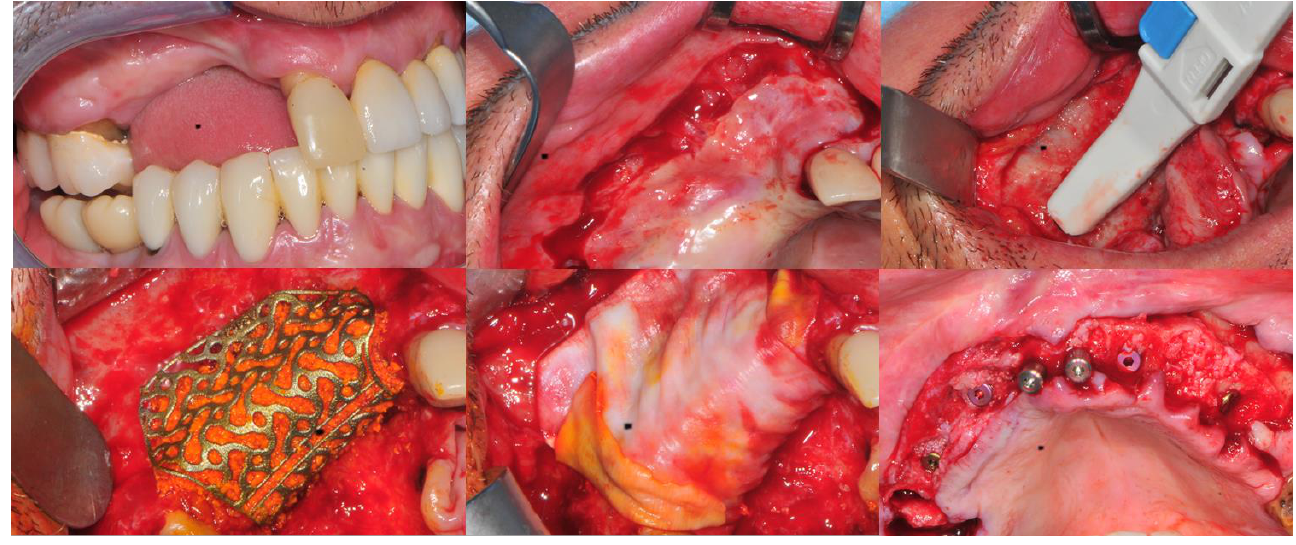
Figure 2. CBR involving upper jaws. Top line, from left to right: initial clinical situation, flap design, bone refreshing. Bottom line from left to right: CBR in place, covering of it with a resorbable mem- brane, implanting of insertion after grid removal and clinical evaluation of the bone quality obtained.